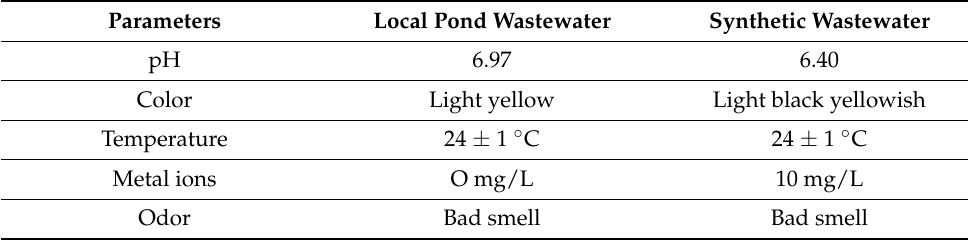
Table 1. Recorded characteristics of local pond and synthetic